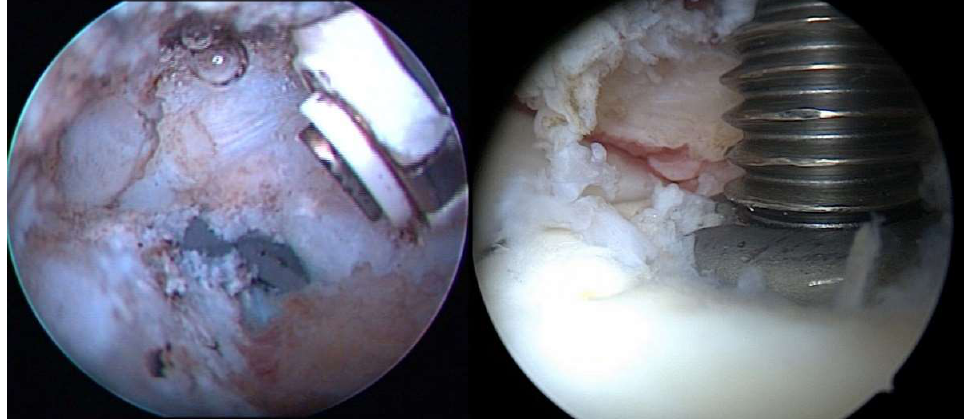
Figure 2. Arthroscopic imagery. ( left ) Fibrous adhesions between the tendon of the supraspinatus muscle and the humeral head with a partially protruding end of the nail; ( right ) extraction of the protruding nail under arthroscopic